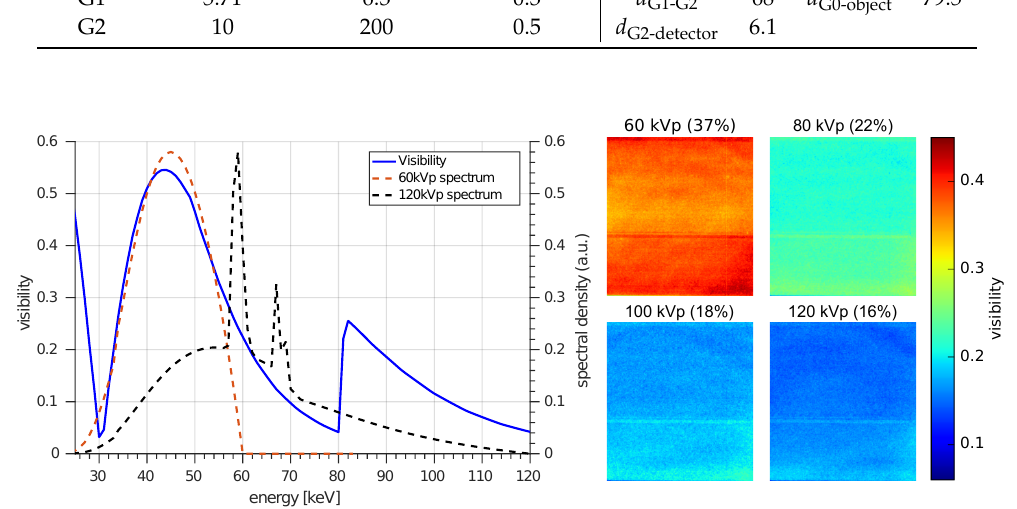
Figure 2. Simulated visibility ( left ) shown in blue for the used setup for energies from 25 to 120keV, referring to the left vertical axis. The dashed lines represent the applied 60kVp (red) and 120kVp (black) spectrum, filtered with 0.3mm copper and an included detection efficiency of 600 µ m CsI, referring to the right axis. The measured reference visibility maps are shown for 60, 80, 100 and 120kVp spectra ( right ). The retrieved average visibility of the polychromatic measurement is denoted in the